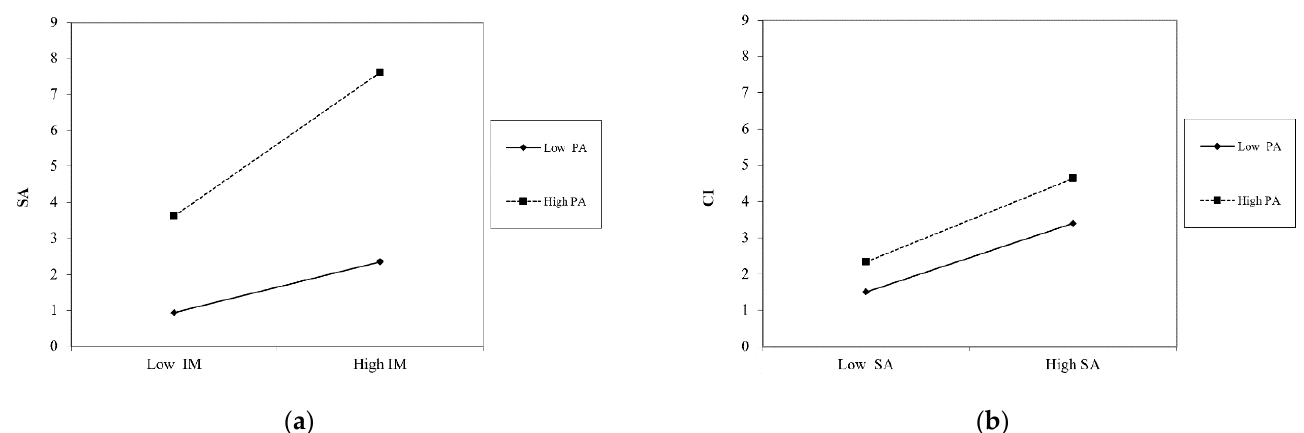
Figure 3. The interaction effects of PA: ( a ) the moderating effect of PA between IM and SA; ( b ) the moderating effect of PA between SA and CI.